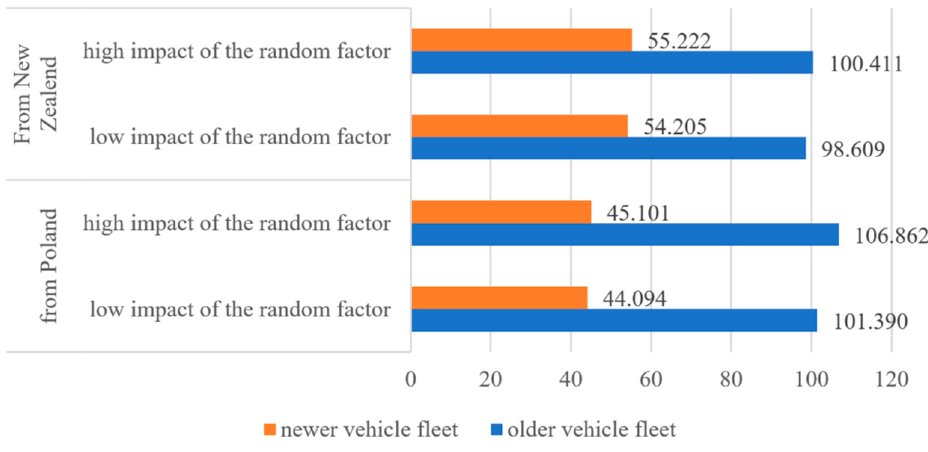
Table 4. CO 2 emission values per kilometre of the supply chain for analysed scenarios for apple suppliers.